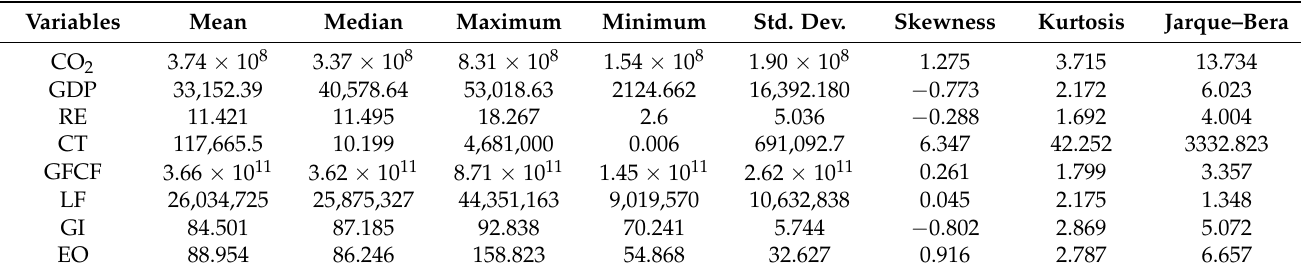
Table 2. The findings of descriptive statistics of the selected variables.